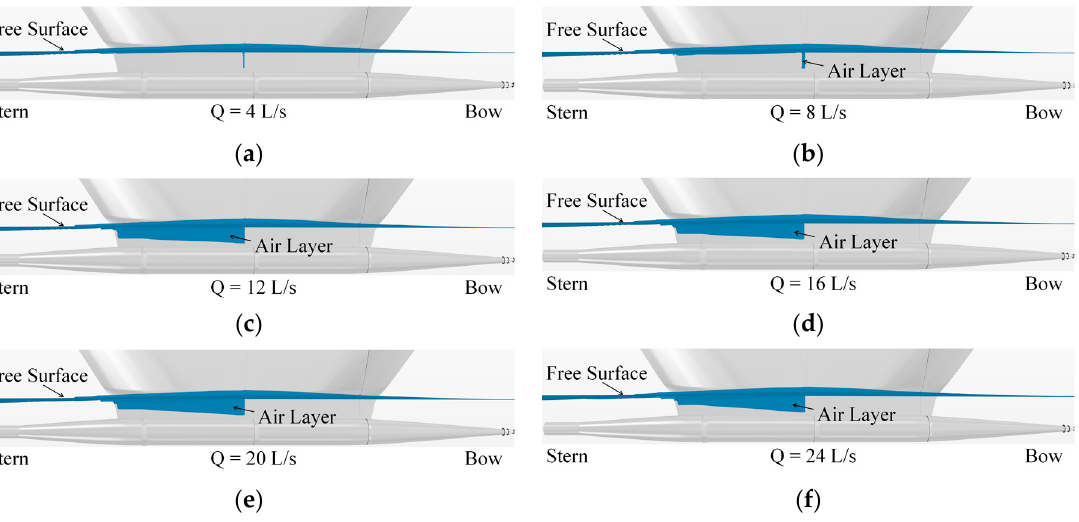
Figure 12. Air layer distribution with air injected from location L6: ( a ) Air fl ow rate Q = 4 L/s; ( b ) Air fl ow rate Q = 8 L/s; ( c ) Air fl ow rate Q = 12 L/s; ( d ) Air fl ow rate Q = 16 L/s; ( e ) Air fl ow rate Q = 20 L/s; ( f ) Air fl ow rate Q = 24 L/s.